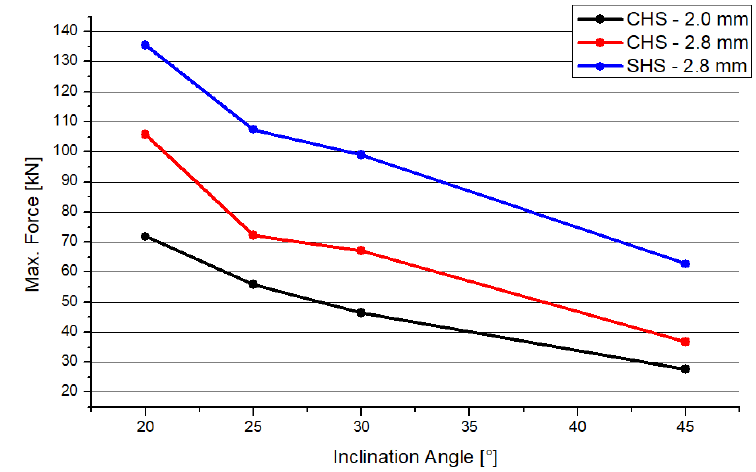
Figure 6. Comparison of the maximum compression